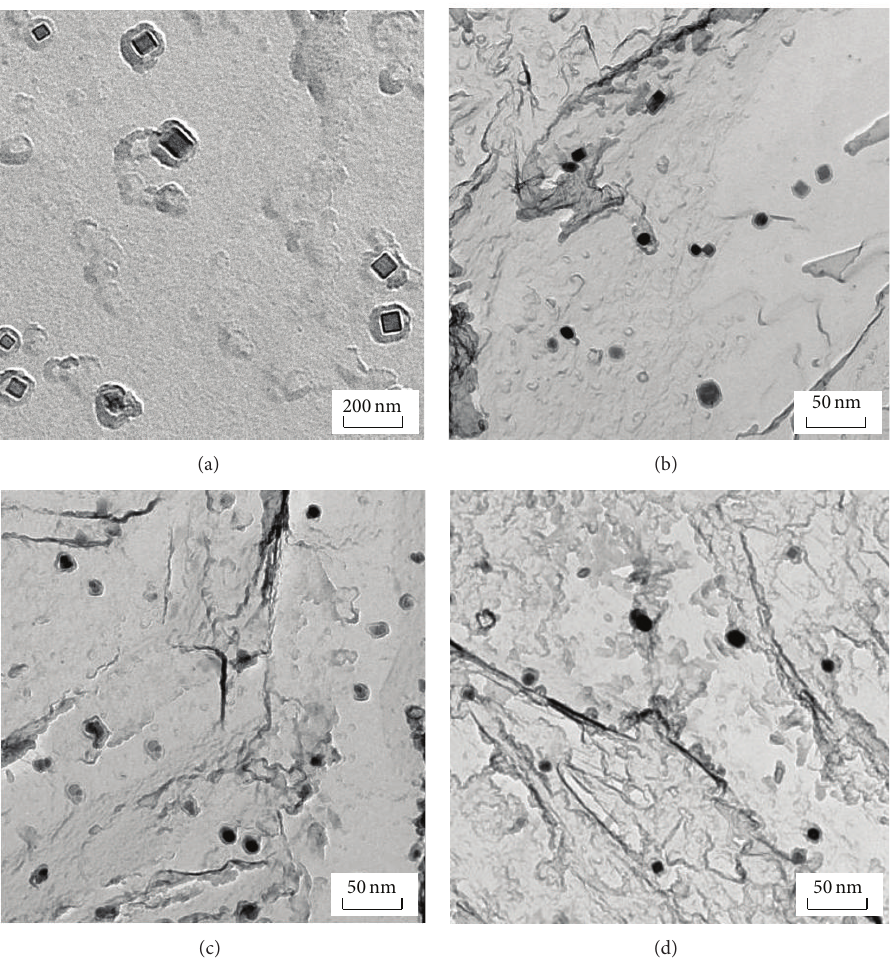
Figure 5: The precipitations under different deformation conditions. (a) 𝜀 = 0.22 , 𝑡 = 10 s; (b) 𝜀 = 0.22 , 𝑡 = 50 s; (c) 𝜀 = 0.35 , 𝑡 = 20 s; (d) 𝜀 = 0.35 , 𝑡 = 50